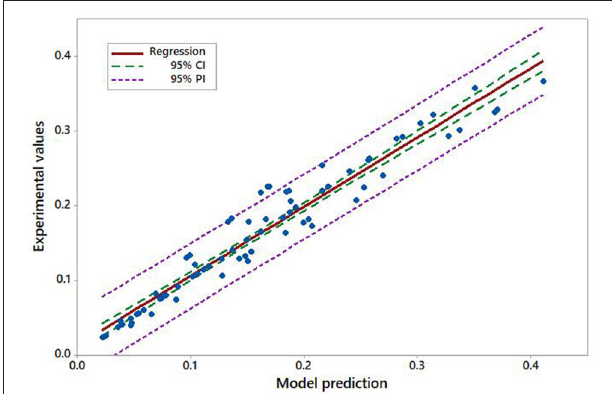
FIGURE 9 | Confidence interval (CI) and prediction interval (PI) for linear regression of experimental and model polymerization rate data (all rate units in mol dm − 3 s − 1